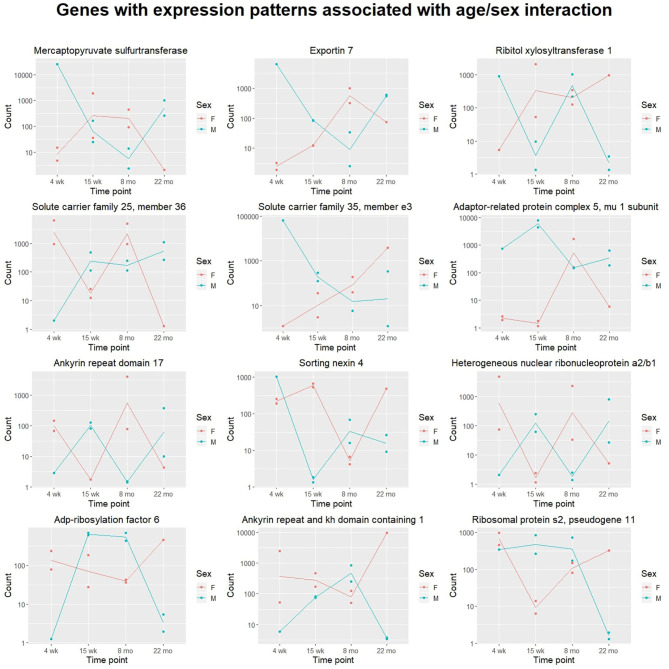
Scatter plots displaying sex-specific expression paths over time. The top 12 genes with canonical names (ranked by adjusted p-value) identified in the likelihood ratio test for age/sex interaction are displayed. For each gene, transcript count is displayed on the y-axis (with logarithmic scale) and age group on the x-axis. Samples from different sexes are colored differently. Expression of each of these genes is highly associated with an interaction between age and sex. Lines are added to display trajectories between mean expression levels for each sex at each time point. Lines for males (blue) and females (red) are colored differently.